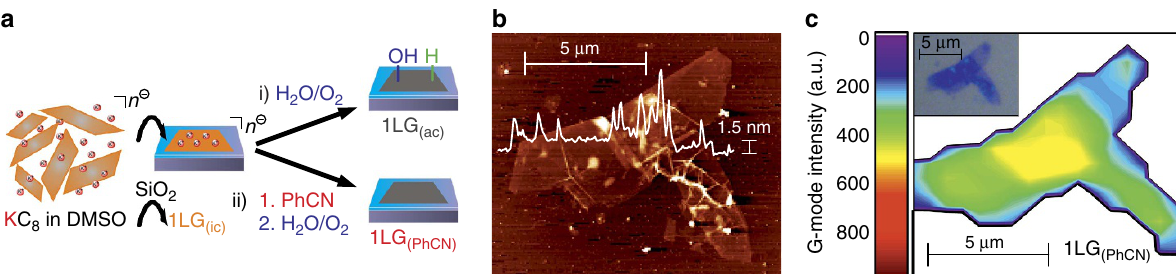
Figure 4 | Production of large-area graphene films for SRM analysis. ( a ) Dispersions of KC 8 in DMSO and drop casting of the corresponding graphenide solutions onto Si/SiO 2 wafers (SiO 2 layer thickness of 300nm) under inert conditions leading to air-sensitive graphenide flakes 1LG (ic) . Before analysis, 1LG (ic) was (i) either directly exposed to ambient conditions (1LG (ac) , black) or (ii) previously washed by PhCN (1LG (PhCN) , red). ( b ) AFM image (scale bar 5 m m) with height profile indicating the single-layer nature of the obtained 1LG (PhCN) with lateral dimensions of B 10 m m with a height of B 1.5nm. Note that the overlap of two single layers in the centre of the flake can be revealed by the underlying z-profile. ( c ) Corresponding SRM map showing the respective G-mode intensity in relation to the optical image shown in the inset.